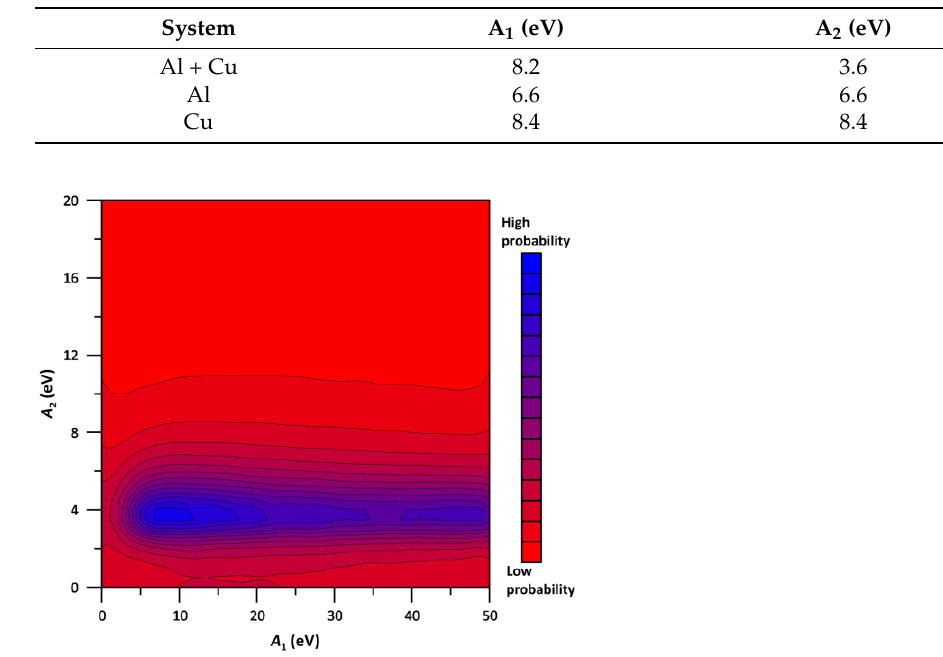
Figure 13. Bayesian identification of the strain rate parameters Α 1 and Α 2 for the Al-Cu bisystem: Probability distribution in the parameter space based on 40,000 trial pairs of parameters. Table 1. Identified parameters of the strain rate sensitivity for different systems.